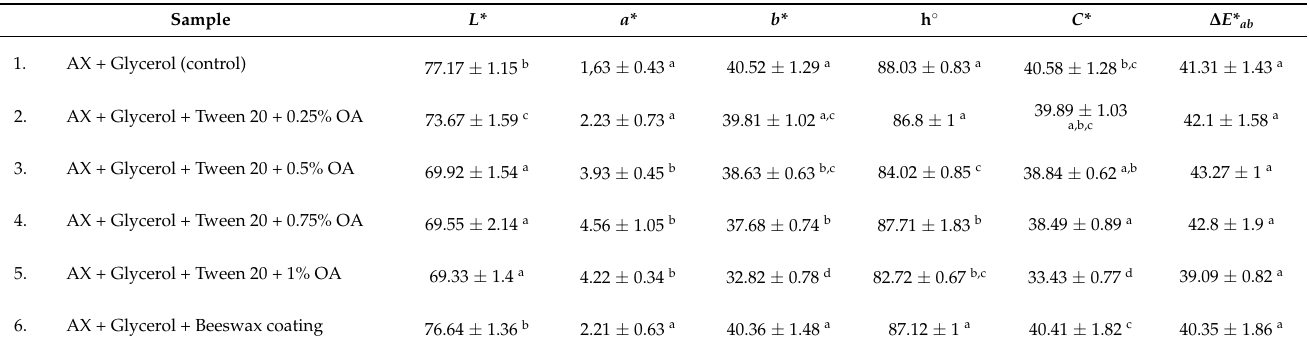
Table 6. Values of lightness ( L* ), chromaticity coordinates ( a* , b* ), the calculated hue ( h ◦ ), chroma ( C* ), and composite colour difference ( ∆ E* ab ) for all the films samples. Values in the same column followed by different superscript letters differ significantly ( p <